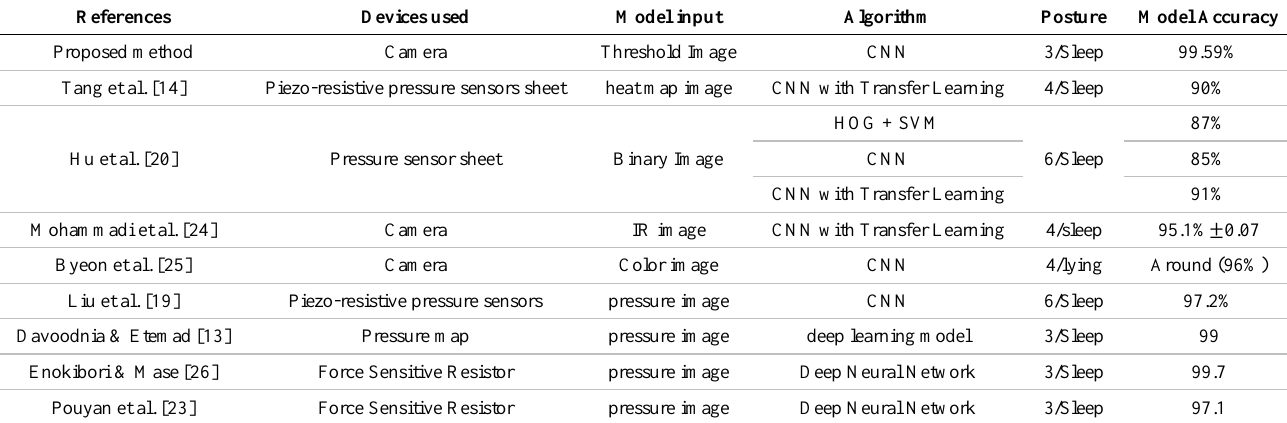
Table 2. Comparison between proposed work and existing